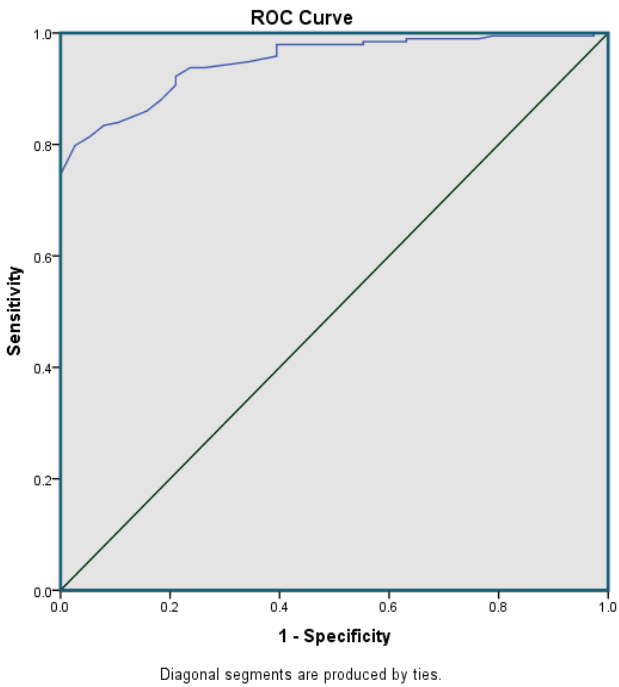
Figure 4. ROC curve of the single CPD parameter used to distinguish reactive cases from neoplastic cases (AUC: 0.948; 95% CI: 0.921–0.976; Cut-off: 147.5; Sensitivity: 78.47%; Specificity: 80.43%).